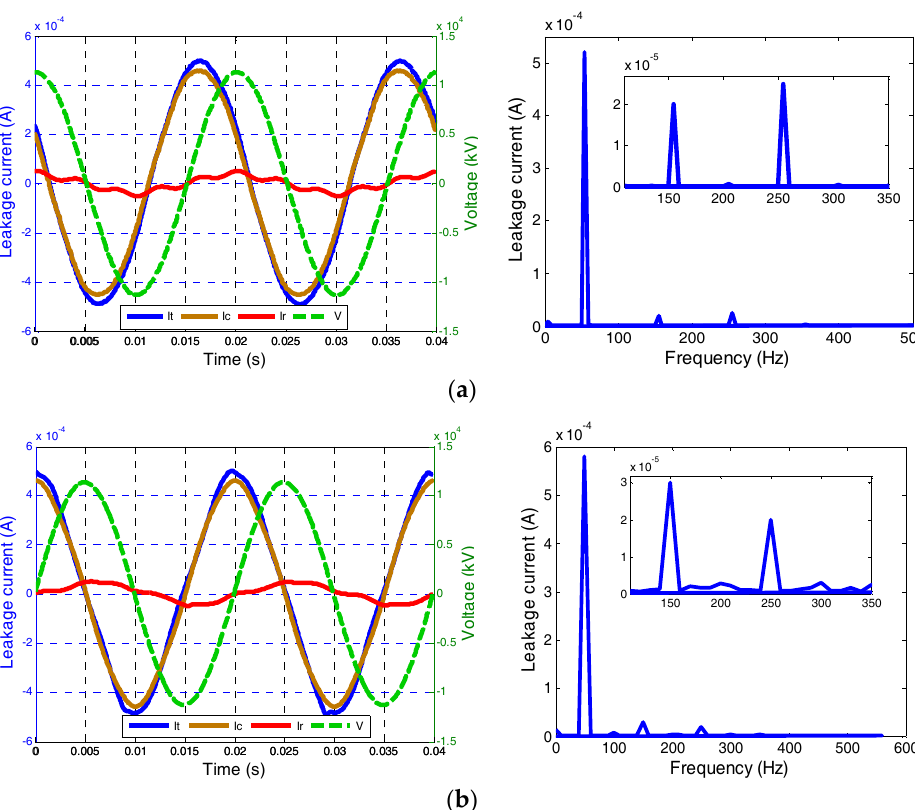
Figure 14. Leakage current waveforms and harmonic components at 8 kV rms applied voltage with salt water on the surge arrester from the ( a ) measurement; ( b ) FEA model.